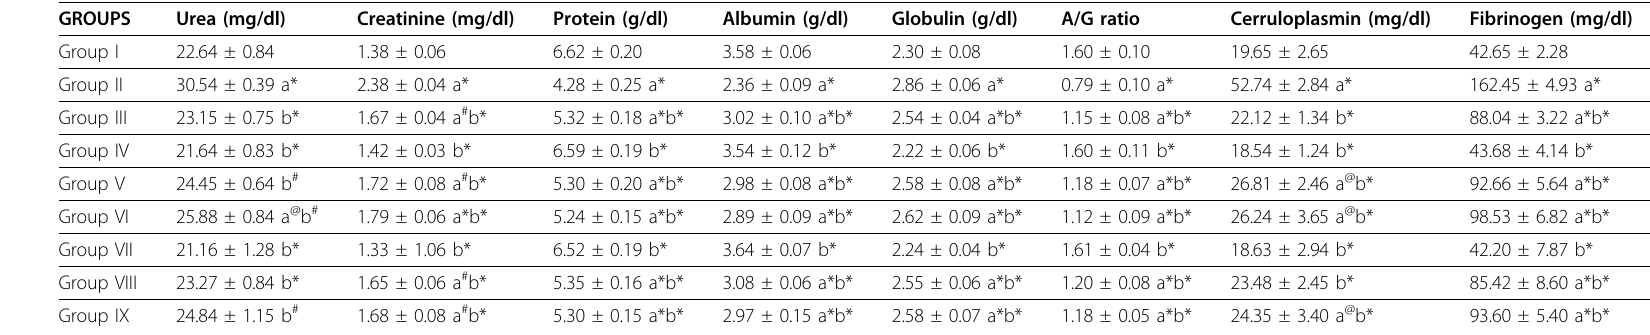
Values are Mean ± S.E.M, n = 6 animals in each group. Comparisons were made between: a- Group I vs II, III, IV, V, VI, VII, VIII, IX. b- Group II vs III, IV, V, VI, VII, VIII, IX. c- Group III vs V, VI, VIII, IX. Symbols represent statistical significance: * - p < 0.001, # - p < 0.01, @ - p < 0.05. in adjuvant induced arthritic